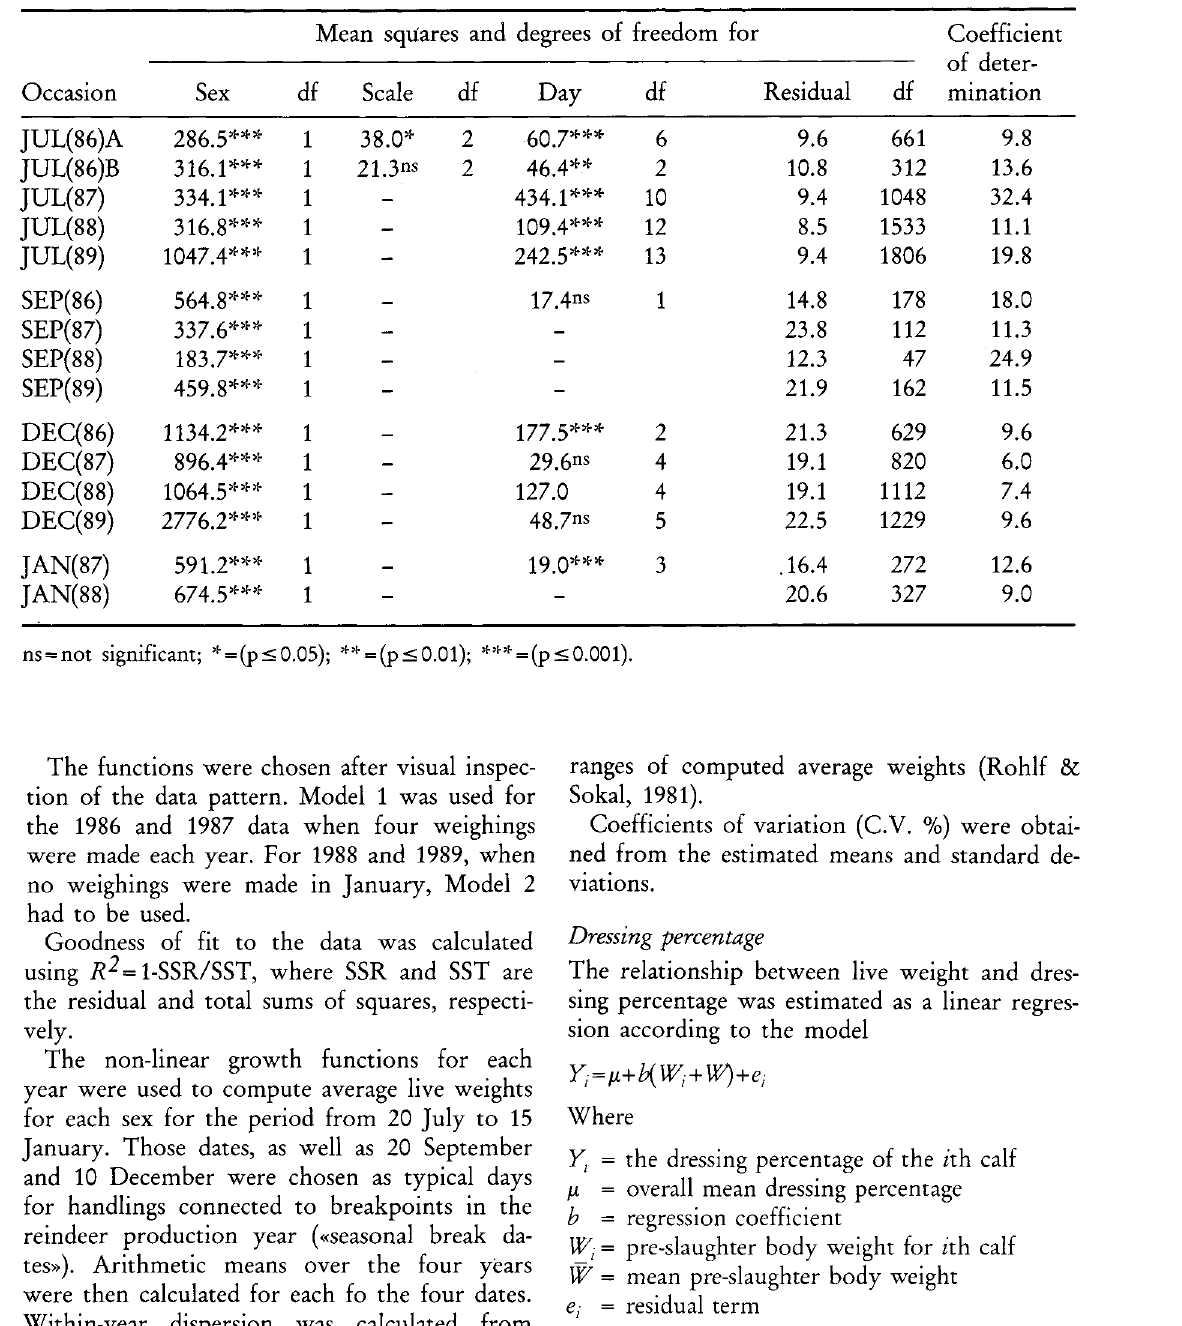
Table 2. Analyses of variance in observed weights of the reindeer calves at JUL, SEP, DEC, JAN. Mean squares and degrees of freedom for